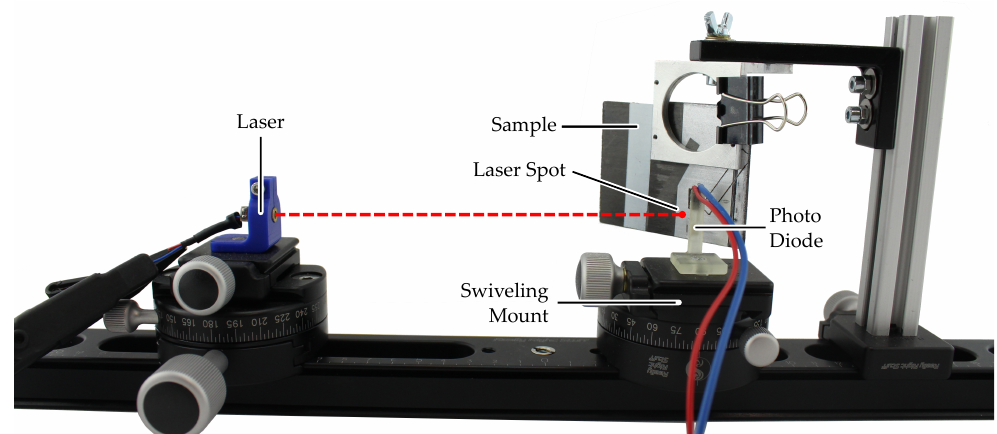
Figure 5. Measurement setup for directional reflectance measurement of painted surfaces. The laser illumination source is mounted on the left and adjusted so that the laser spot is focused on the material sample surface. The photo diode can be rotated around the center of the mount, keeping the distance between sample surface and photo diode constant.